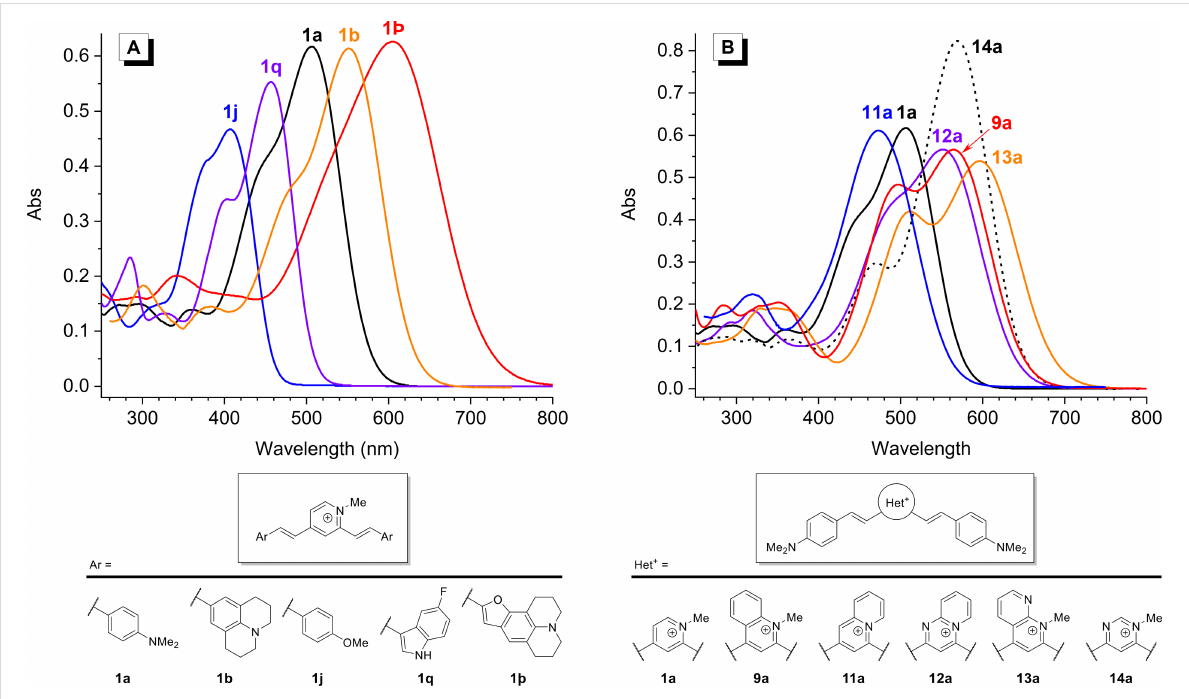
Figure 4: Representative absorption spectra of the distyryl dyes ( c = 10 µM in MeOH) demonstrating the influence of the molecular structure on the optical properties. A) Variation of Ar groups. B) Variation of the Het + core.